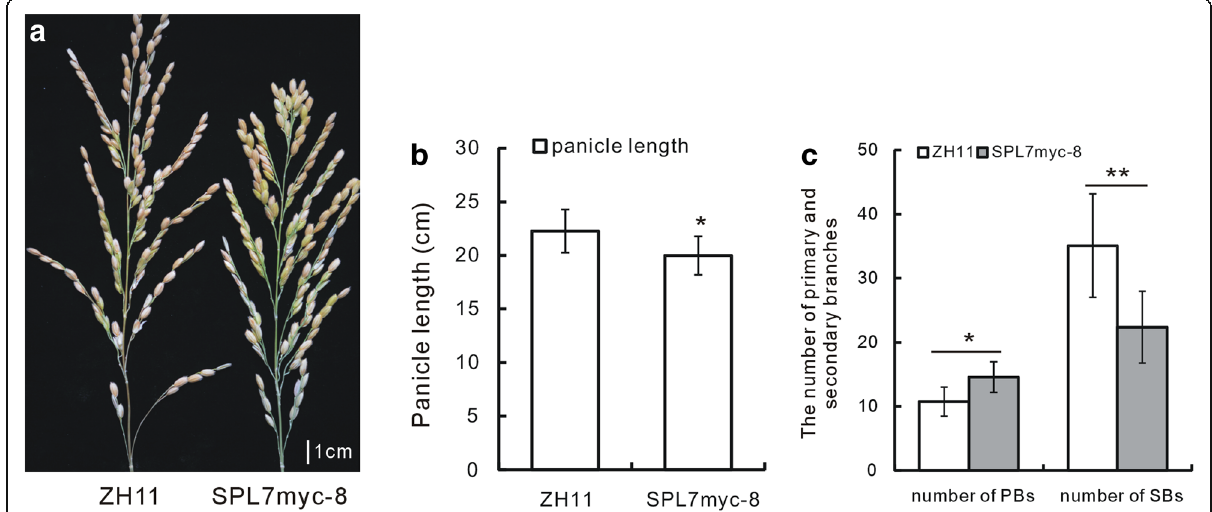
Fig. 3 Panicle characters of the SPL7myc-8 line. a Morphology of the panicles of the WT and the SPL7myc-8 line. b Statistical analysis of the panicle length of the WT and the SPL7myc-8 line ( n = 20). c Statistical analysis of the number of the PBs and SBs of the WT and the SPL7myc-8 line ( n = 20). Single and double asterisks represent significant difference determined by the Student ’ s t -test at * P < 0.05 and ** P <